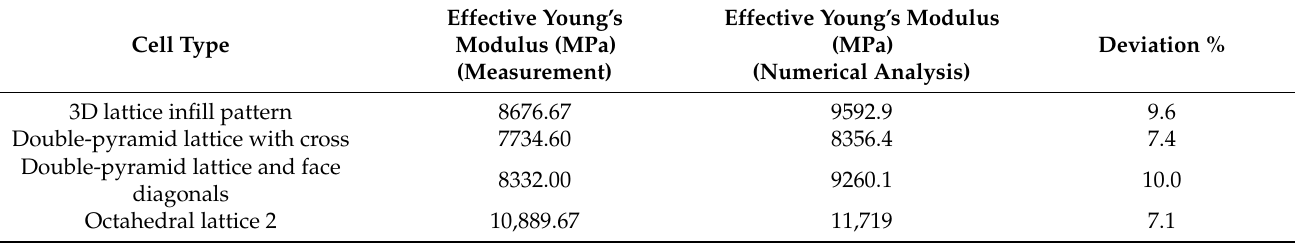
Table 6. Deviation in the values of the effective Young’s modulus for all